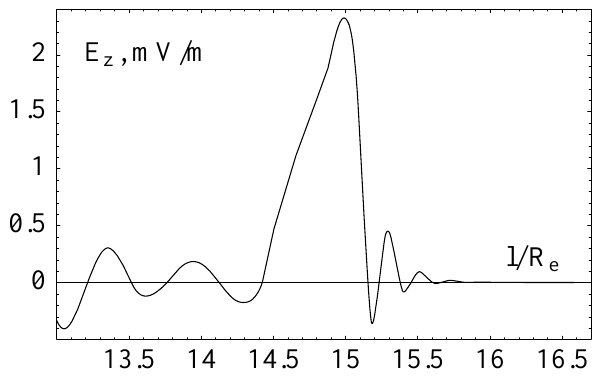
Fig. 14. Wave parallel electric field distribution along the field line near the ionosphere. The ionospheric end corresponds to l max = 16 . 6 R E , the FAST altitude corresponds to l = 16 R E . The parallel electric field is located 1 R E above the FAST